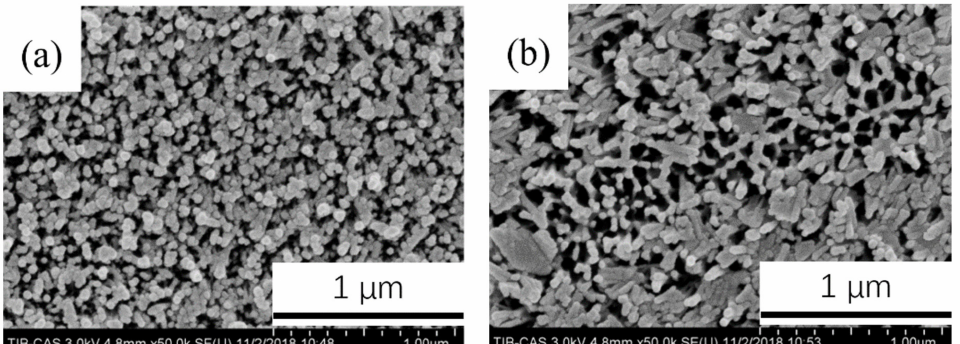
Figure 8. SEM images of 1060 anodic oxide films at different electrolyte concentrations: ( a ) 4 wt%; ( b ) 10 wt%.